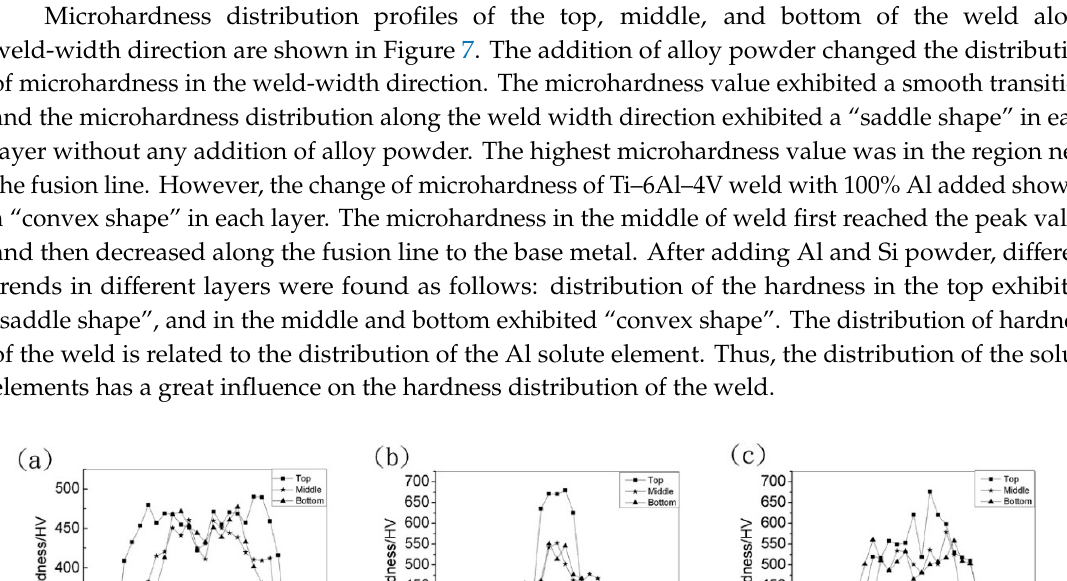
Figure 6. The comparison of longitudinal acicular martensite length.